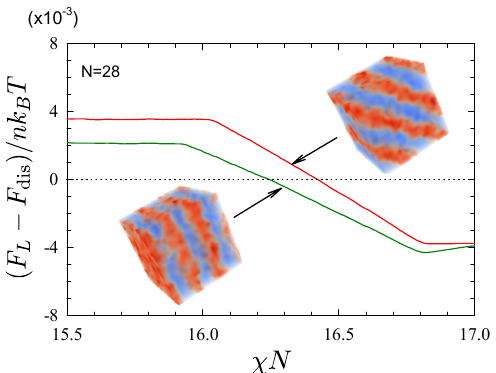
Figure 3. Free energy difference between lamellar and disordered phases, F L − F dis , from thermody- namic integration for molecules of polymerization N = 28 for two different lamellar periods. The kinks at small and large χ N result when the metastable phase switches to the stable phase. Adapted from Ref. [48].